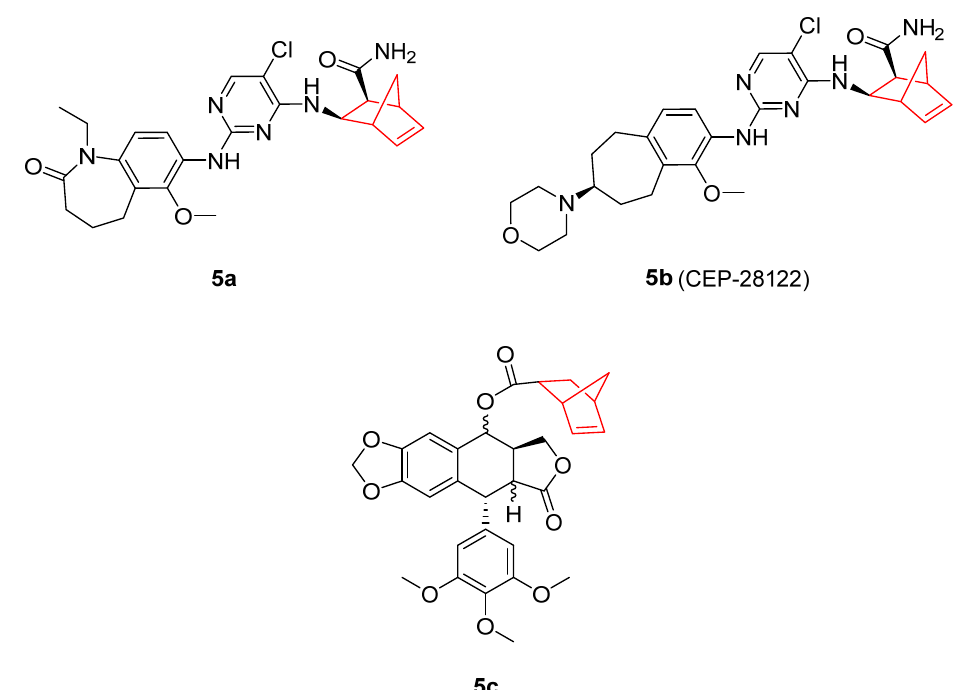
Figure 5. Anaplastic lymphoma kinase inhibitors containing norbornene (compounds 5a–b ) [49–51]. Podophyllotoxin–norbornene derivative (compound 5c )